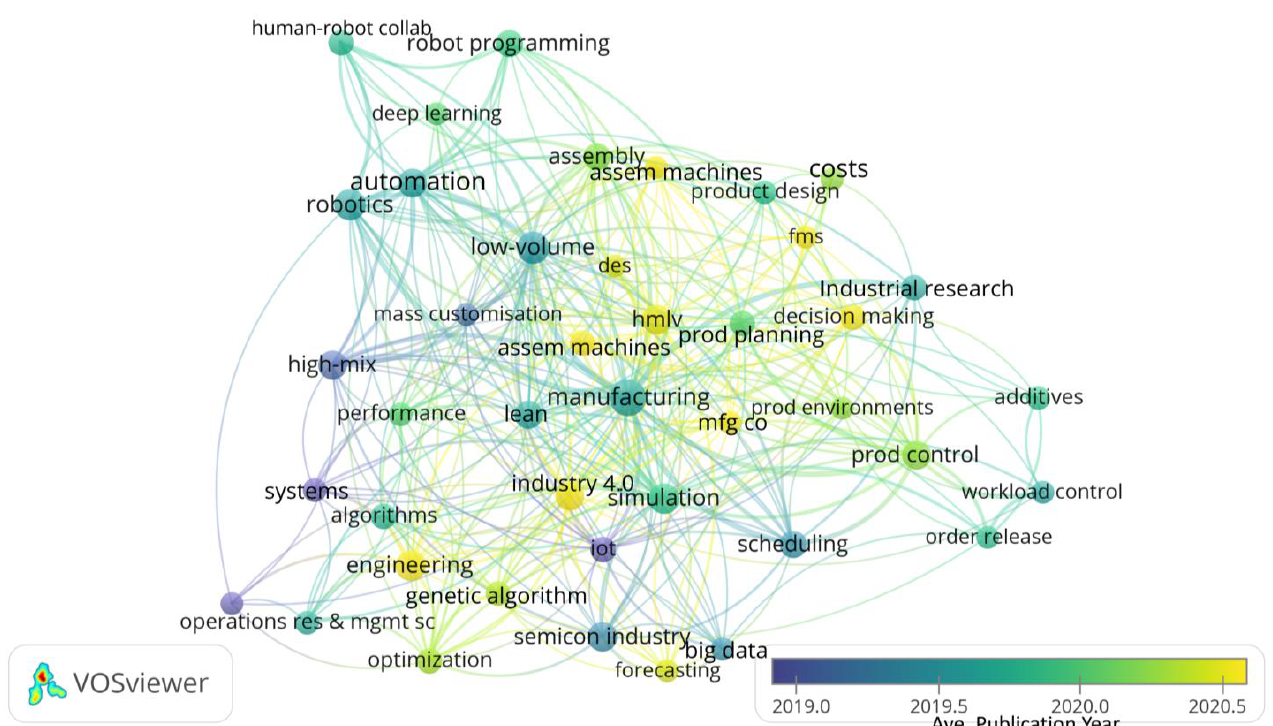
Figure 7. Publication keyword co-occurrence according to topics’ average publication year (2017– October 2022 phase).